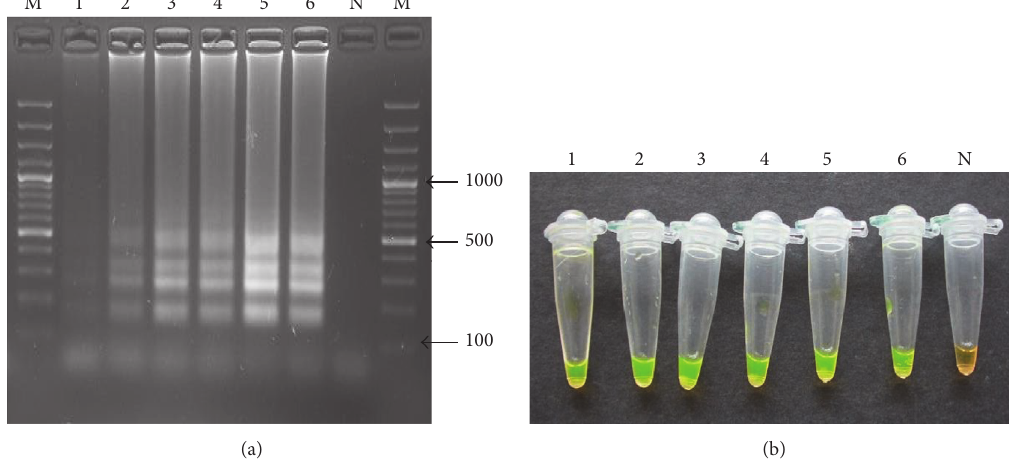
Figure 2: (a) Shows the sensitivity of LAMP visualized by 2% agarose gel electrophoresis. Lanes 1, 2, 3, 4, 5, and 6 are DNA extracted from 1, 5, 10, 15, 20, and 25 eggs, respectively. Lane M is the 100 bp molecular marker and N is the negative control. (b) LAMP visual detection for color change using the SYBR Green dye. Tubes 1, 2, 3, 4, 5, and 6 represent DNA extracted from 1, 5, 10, 15, 20, and 25 eggs, respectively, through 6. N is negative control.